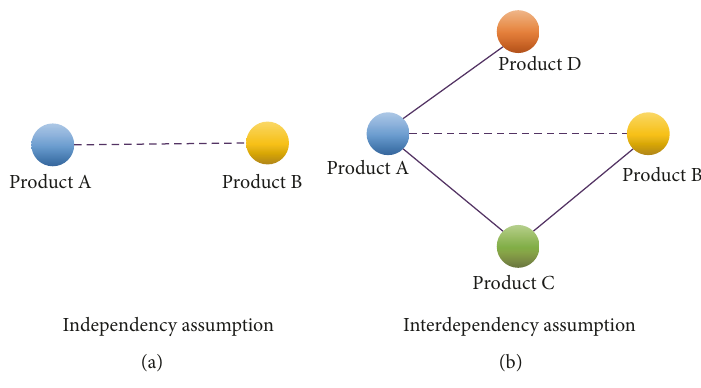
Figure 2: Two dependence assumptions underlying the coconsideration